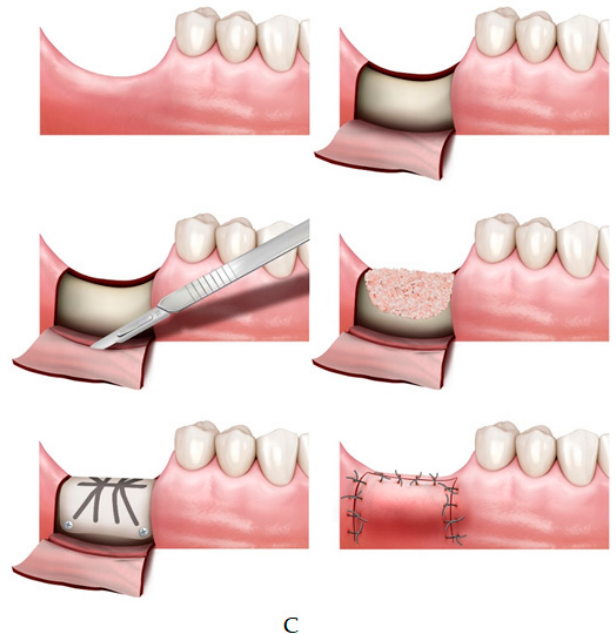
Figure 2. ( A ) Tissue expansion and tunneling graft (TET) group; tissue expander insertion with tunneling bone graft technique. ( B ) Tissue expansion and conventional bone graft (TEG) group; tissue expander and bone graft with conventional guided bone regeneration technique. ( C ) Control; full flap guided bone regeneration (GBR) without tissue expander insertion.